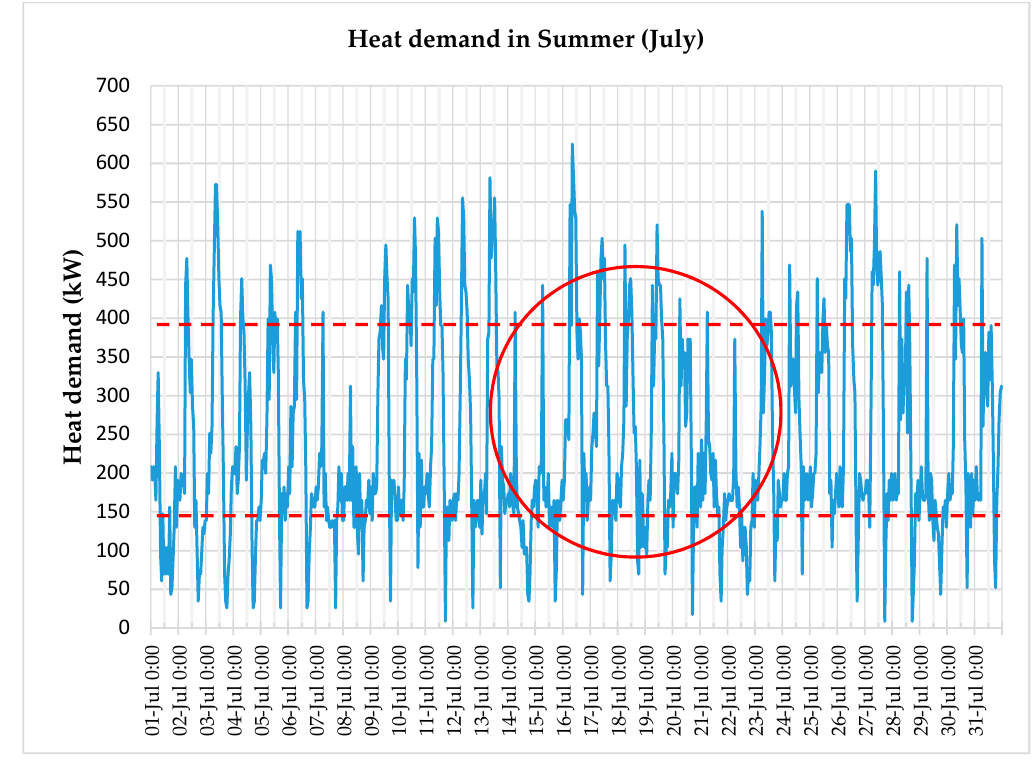
Figure 11. Heat demand in July.